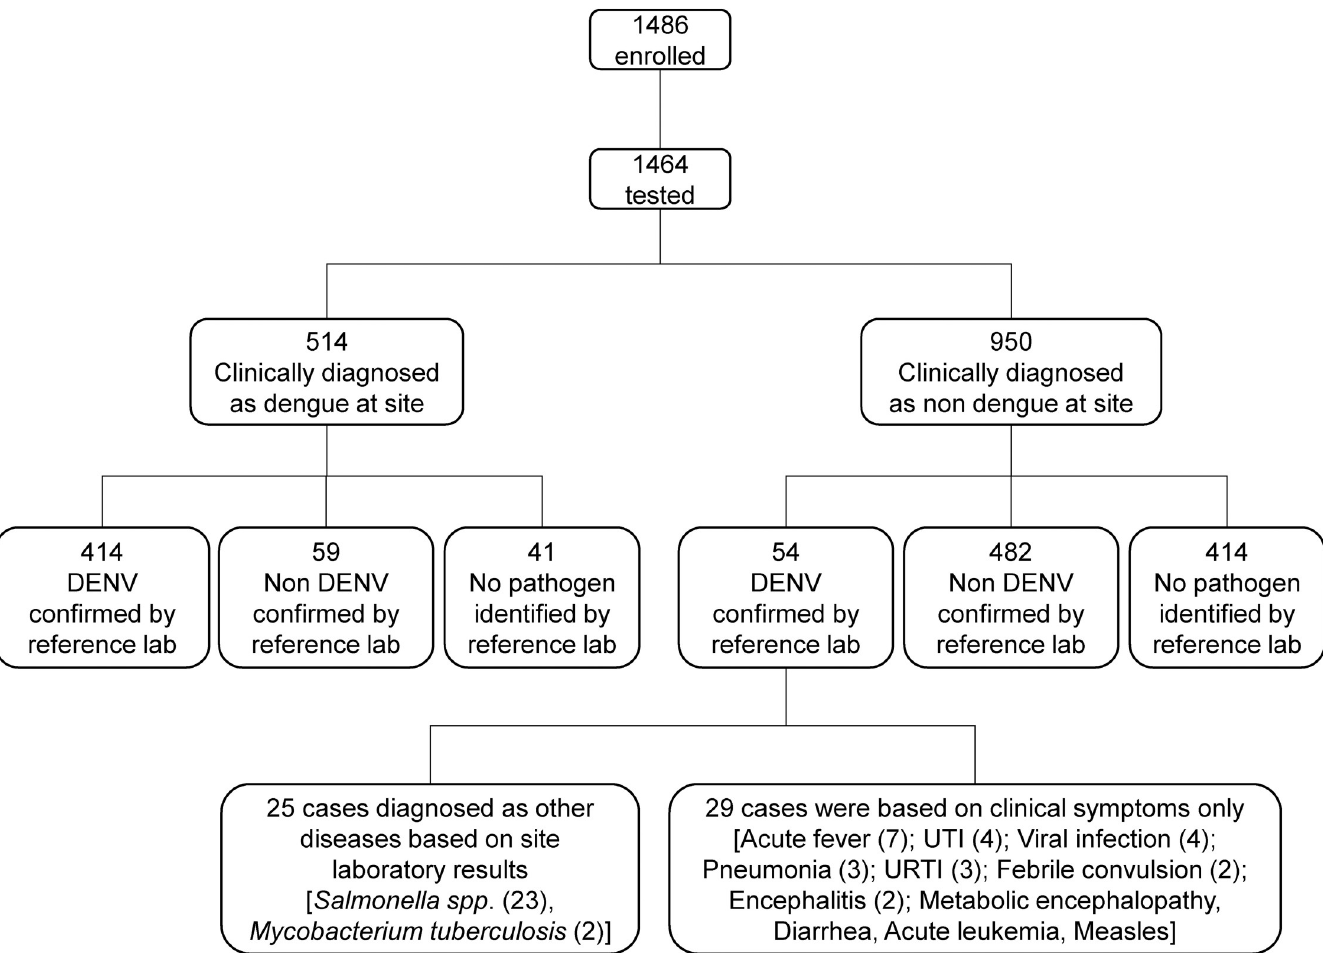
Fig 4. Clinical diagnoses and reference lab confirmation of DENV infections. Presumed etiologies of missed DENV infections and actual etiologies of incorrectly presumed DENV infections are shown. Reference laboratory diagnosis was considered the true diagnosis.